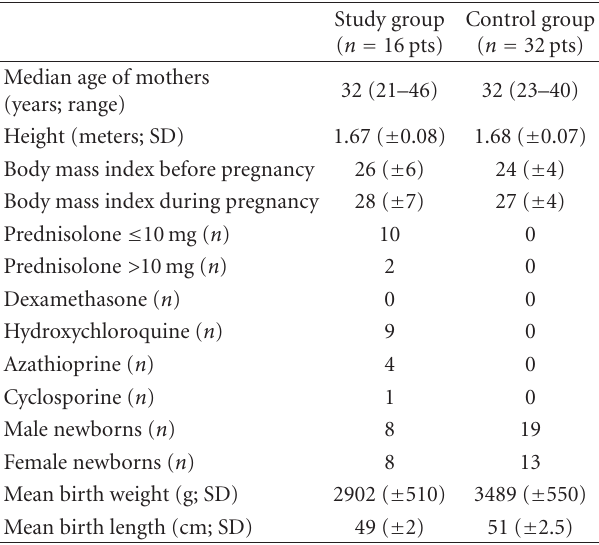
Table 1: Baseline characteristics of the